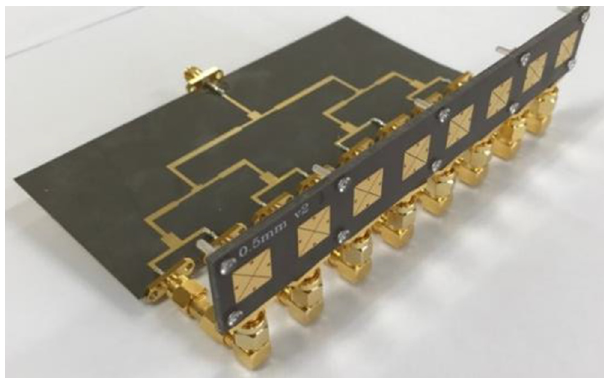
Fig. 18. Photograph of the fabricated 1 (cid:3) 8 MZR array with phase delay lines for the steering angle of 0 ° .